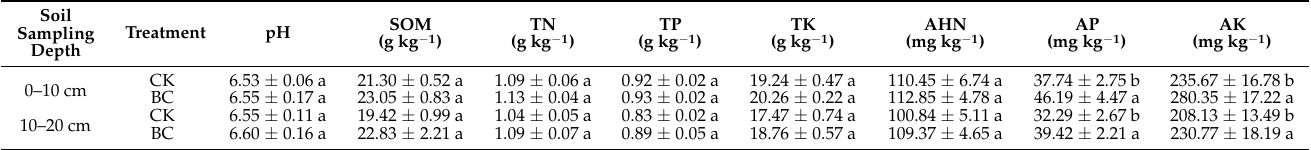
Table 2. Effects of biochar on soil nutrients in dry direct-seeded rice field.